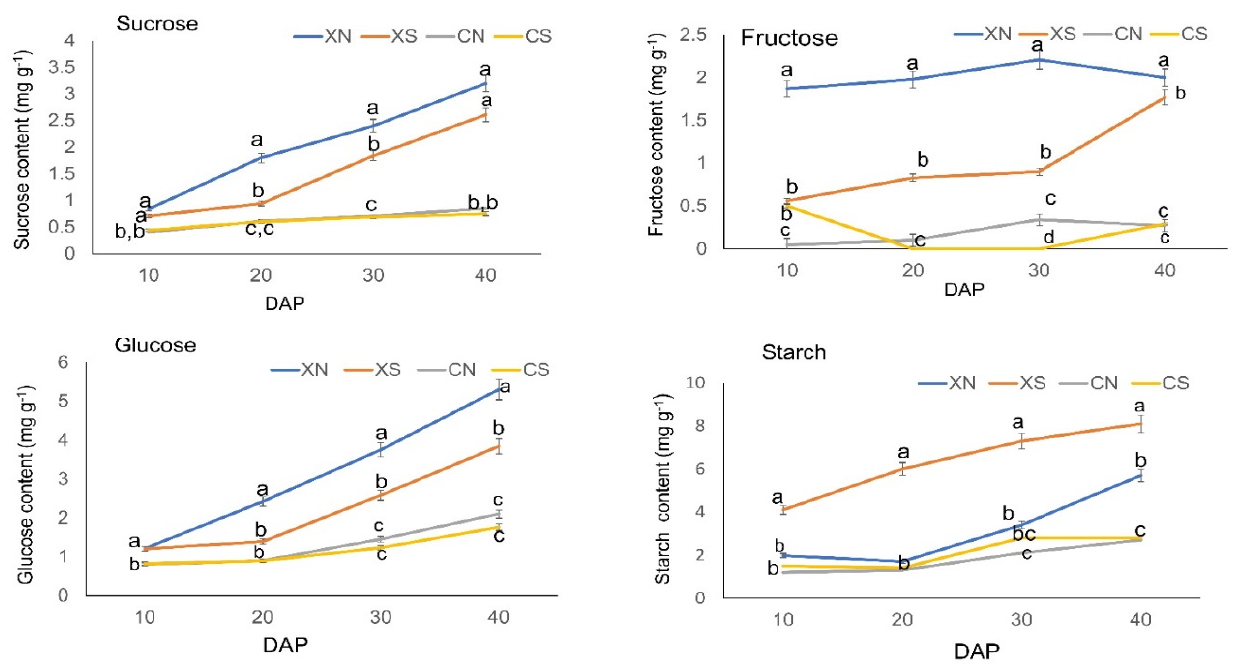
Figure 2. Carbohydrate profiles. The relative content of sucrose, fructose, glucose, and starch is influenced by photoperiod levels in the endocarp of the two cucumber varieties over time (DAP; days after pollination). Vertical bars represent the standard error of means ( n = 3). Means with the same letters within each sampling day are not significantly different according to Tukey’s t -test ( p ≤ 0.05). XN-SWCC8 under day neutral; XS—SWCC8 under a short day; CN—CC3 under day neutral; CS—CC3 under short day.